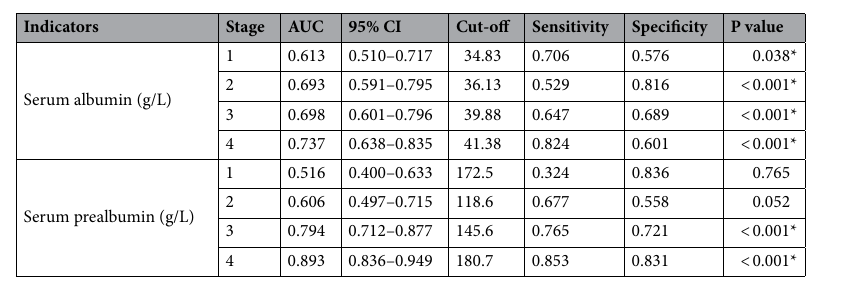
Table 5. ROC curve of albumin and prealbumin for the laparotomy of patients with severe acute pancreatitis.